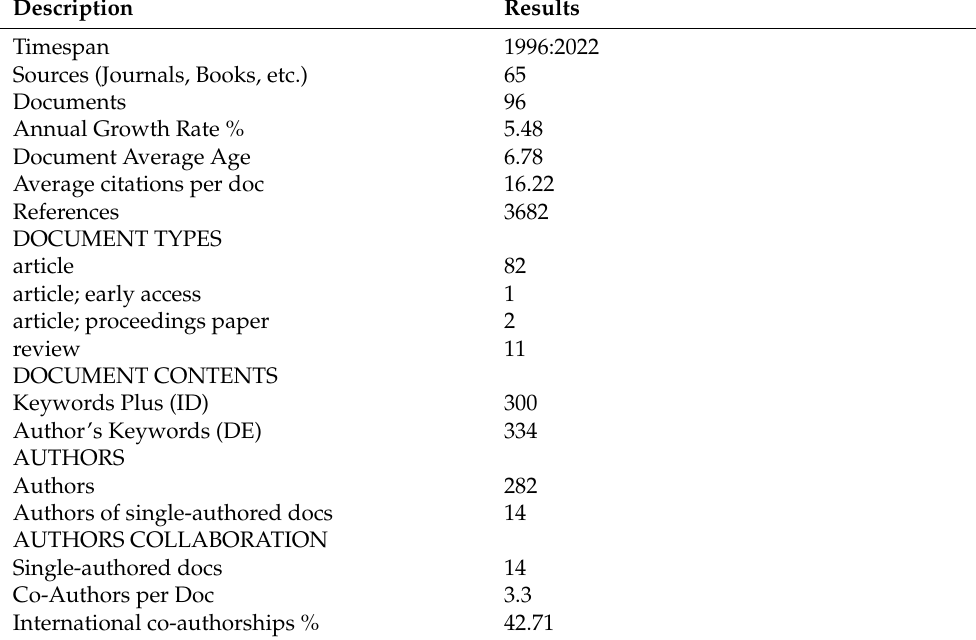
Table 1. Main information about the